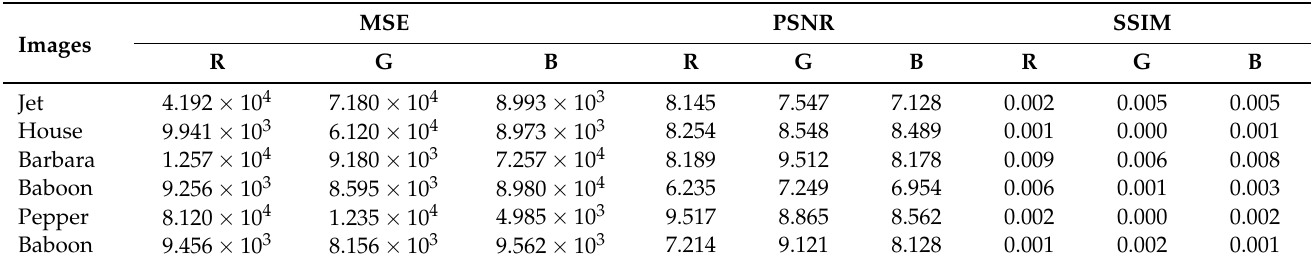
Table 4. Quality measures between input images and output images.